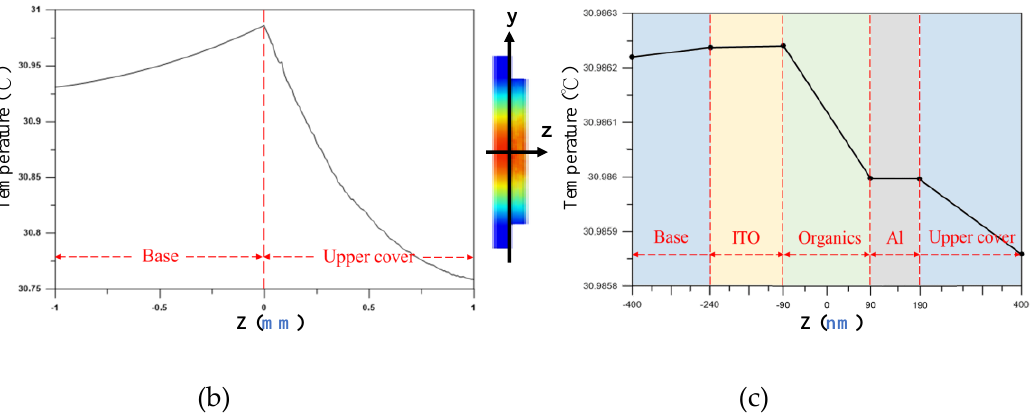
Figure 6. Simulated temperature distributions ( a ) on the upper cover glass and ( b ) along the central cross-section, and ( c ) an enlarged graph of ( b ). The emission area is 1 cm 2 corresponding to the OLED dimension shown in Figure 3.